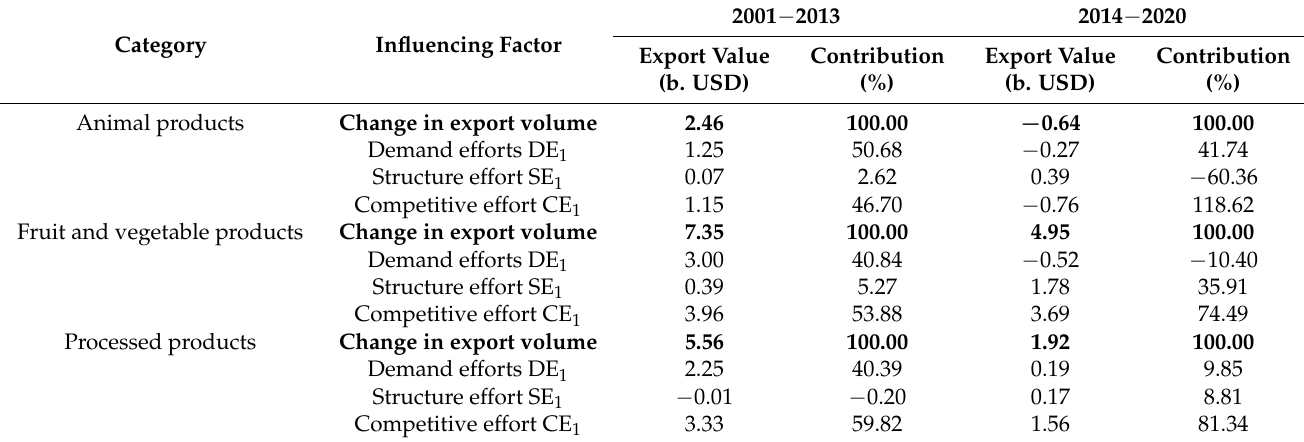
Table 5. Empirical results of the distribution of China exports agricultural to B&R